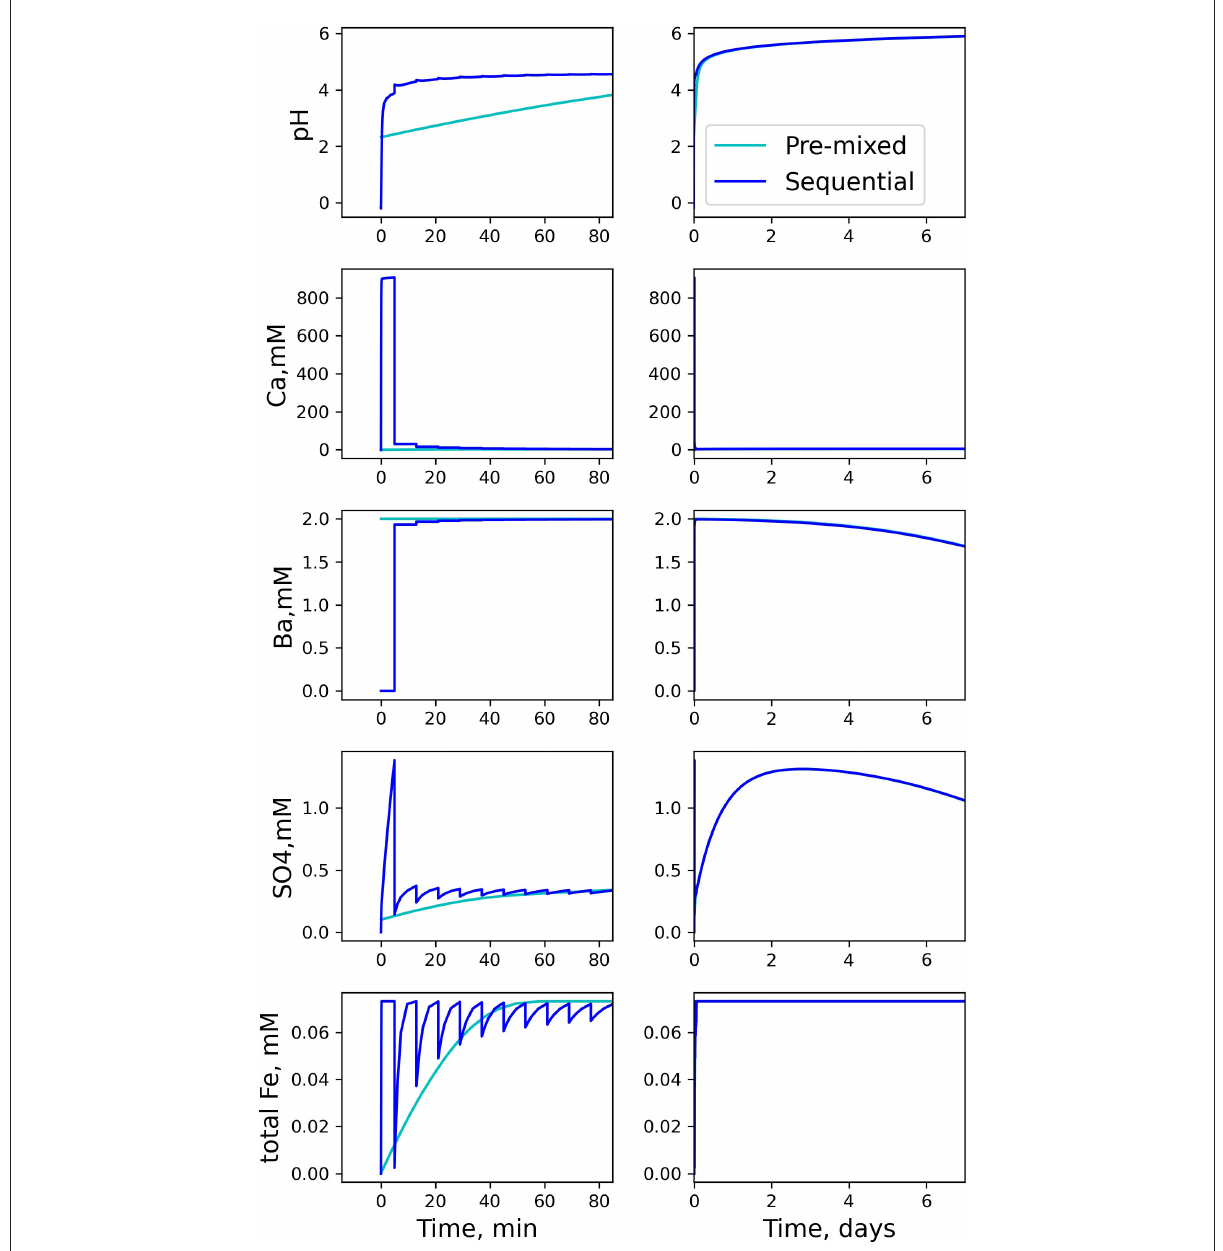
FIGURE3 Aqueous compositions modeled with pre-mixed and and sequential protocols in a 0D batch system. Due to low water-to-rock ratios and strong acidity in the initial steps in the sequential model, the concentrations at early time change dramatically relative to the pre-mixed model. After several hours, the two models have similar